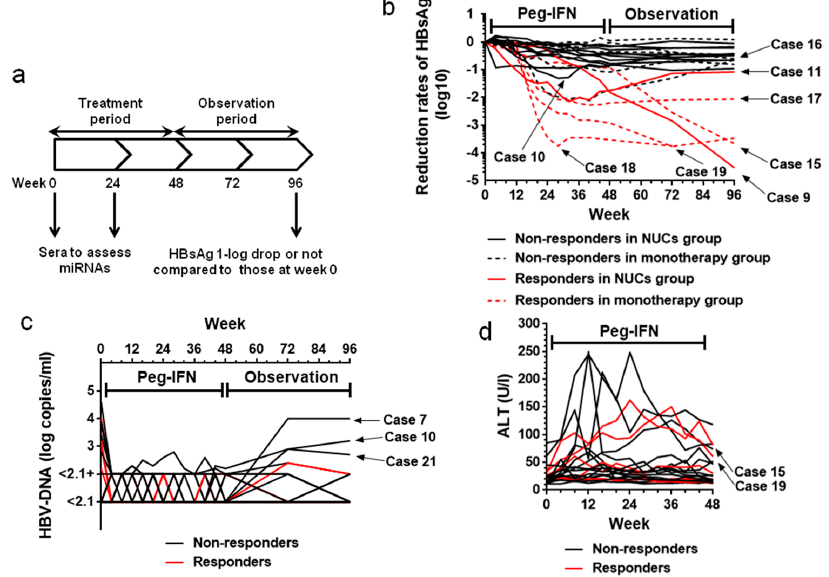
Figure 1. The clinical course of the patients through the treatment and observation periods. ( a ) Study design; ( b ) Reduction rates of serum HBs antigen (HBsAg) levels from baseline through the 48-week treatment and 48-week observation periods (black lines for non-responders in the nucleos(t)ide analogues (NUC) group; black dotted lines for non-responders in the monotherapy group; red lines for responders in the NUC group; red dotted lines for responders in the monotherapy group).